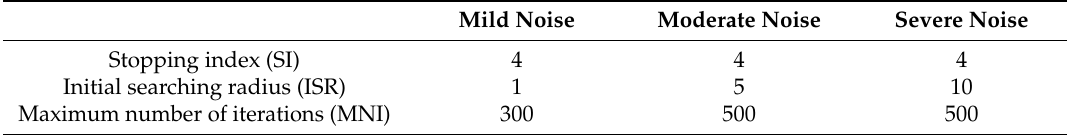
Table 2. Hyperparameter settings for the star images of three di ff erent amount of noise. Mild